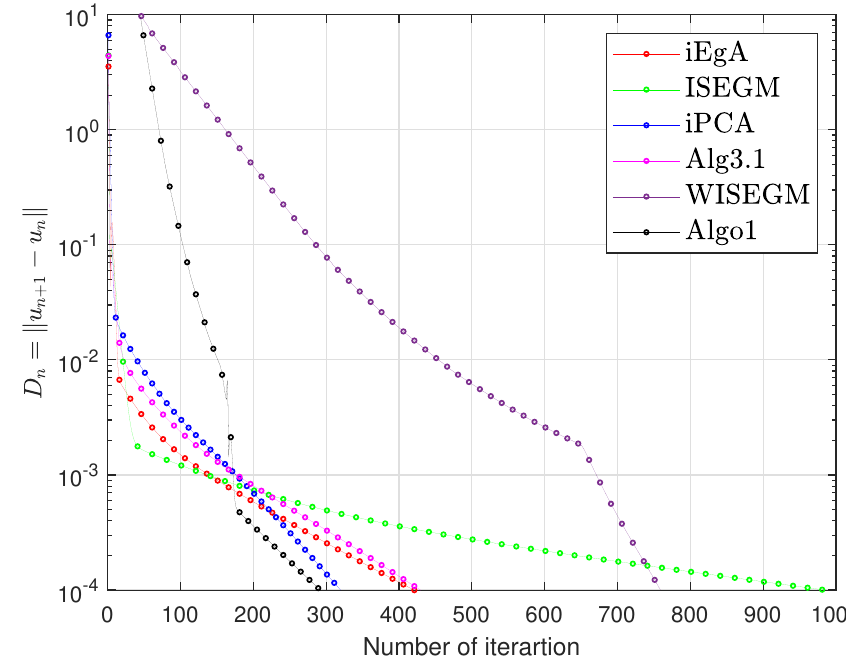
Figure 3. Example 1 in R 50 : Numbers of iterations 421, 985, 320, 430, 759, 292 respectively.